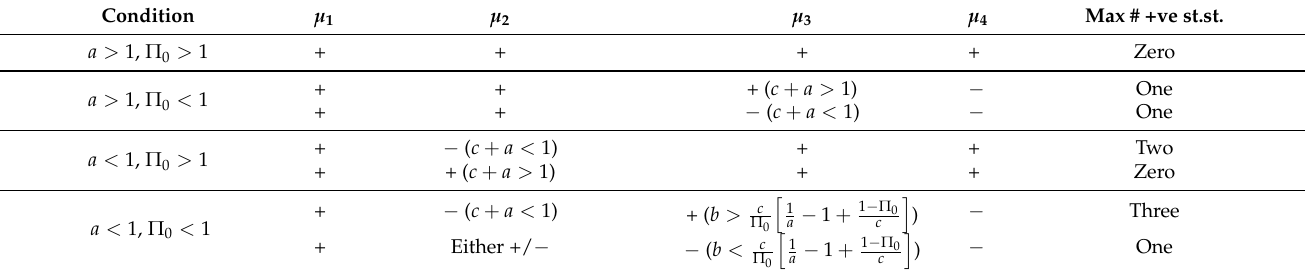
Table 1. Sign of polynomial coefficients which can be used with Descartes’s rule of signs to determine the number of positive steady states of the model